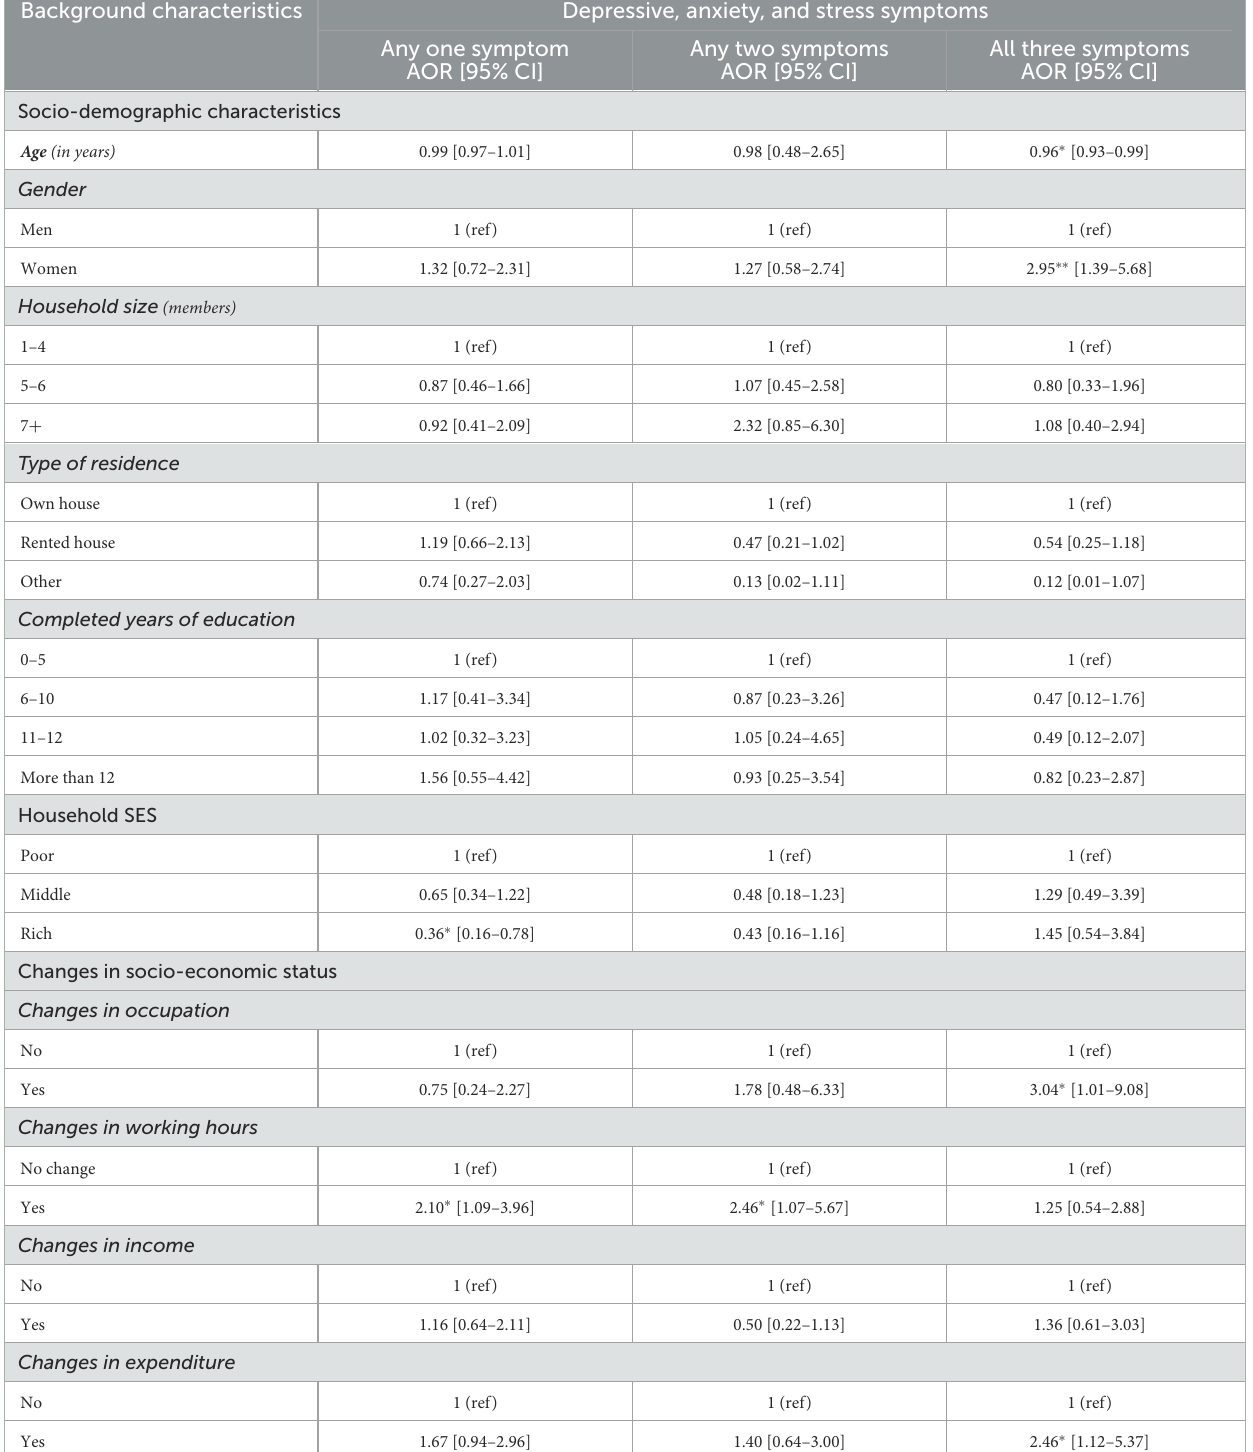
TABLE 3 Adjusted multinomial logistic regression to determine the association between the changes in socio-economic characteristics and mental health-related symptoms (Reference group: No symptoms at all) ( n = 382). Background